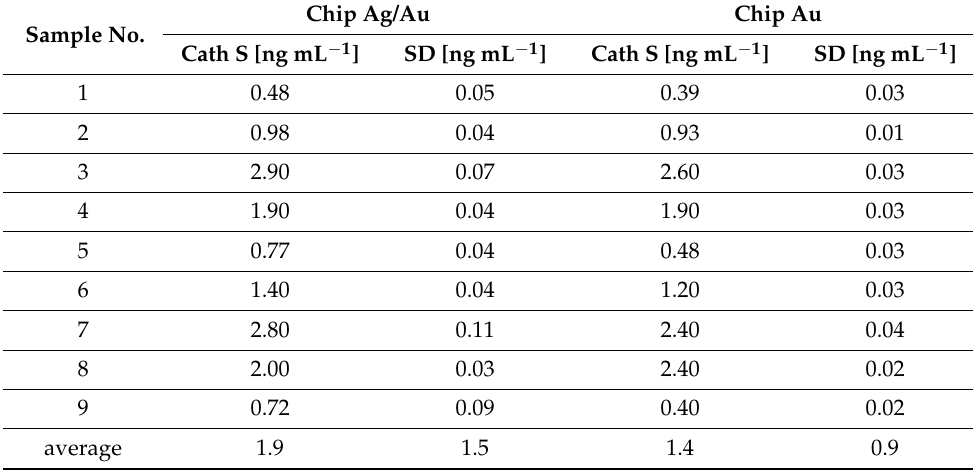
Table 2. Cathepsin S in blood plasma samples of healthy volunteers as determined by biosensors formed on the Ag/Au and Au chips. Sample No.